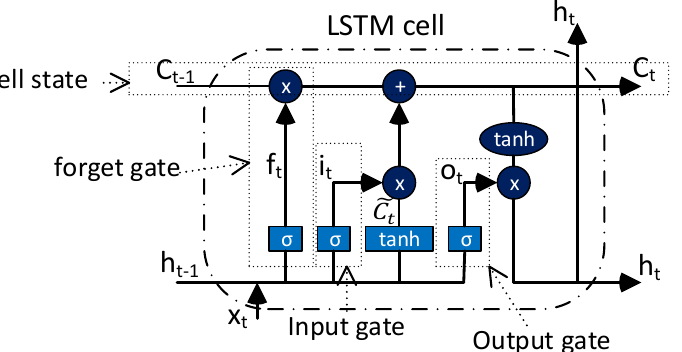
Figure 2. Structure of a LSTM cell.